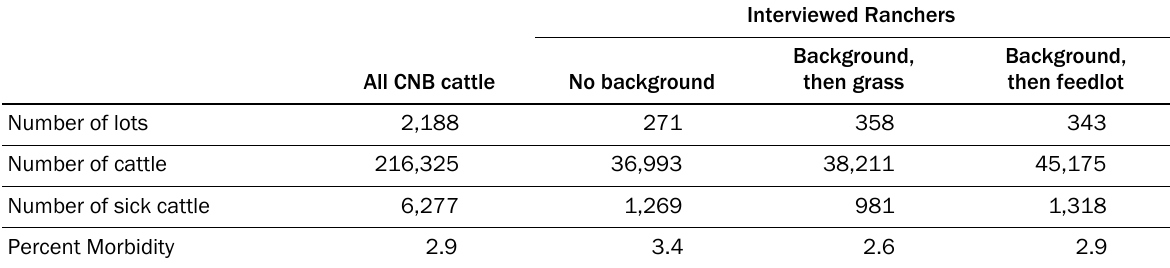
Table 1. Summary of Country Natural Beef (CNB) Program Cattle Morbidity Between 2004 and